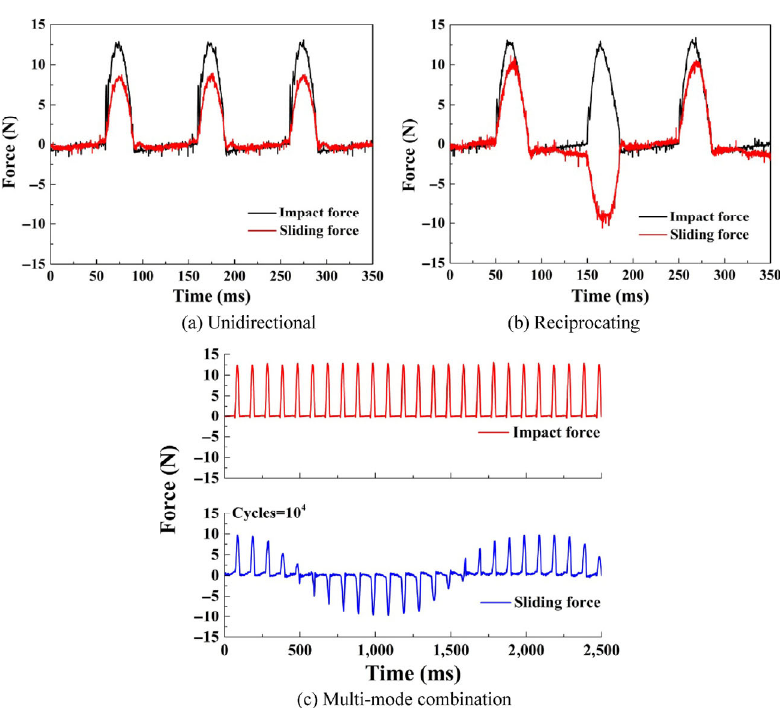
Fig. 10 Impact and sliding force, cycles=10 4